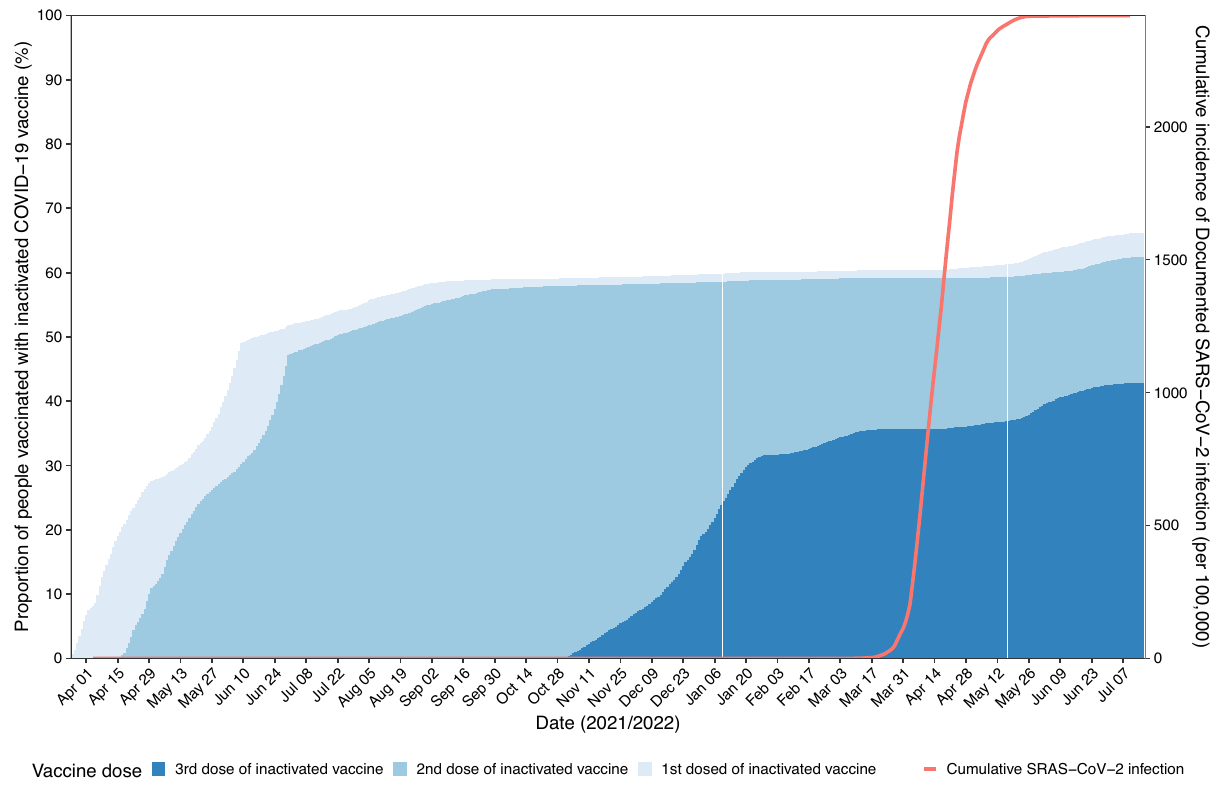
Fig. 1 | Vaccination status and cumulative documented SARS-CoV-2 infections among adults aged ≥ 60 years in Shanghai (25 March 2021 to 16 July 2022). Dusty blue, light blue, and royalblue represent the proportion of people